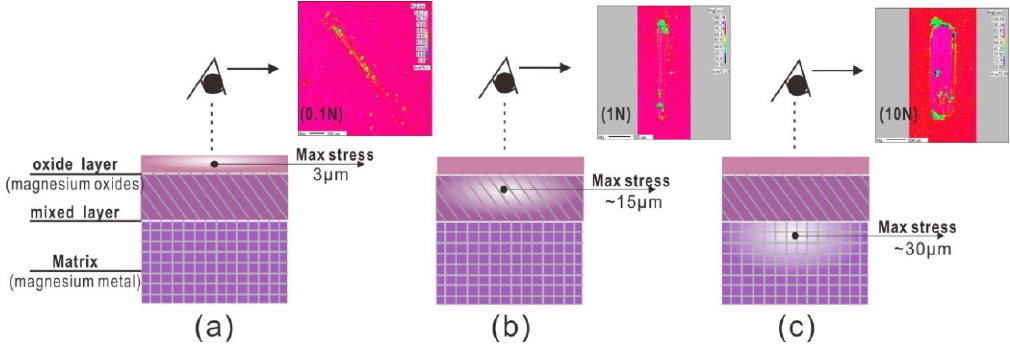
Figure 7. Max stresses at different depth for 100 cycles at different loads. ( a ) 0.1 N, ( b ) 1 N, and ( c ) 10 N.